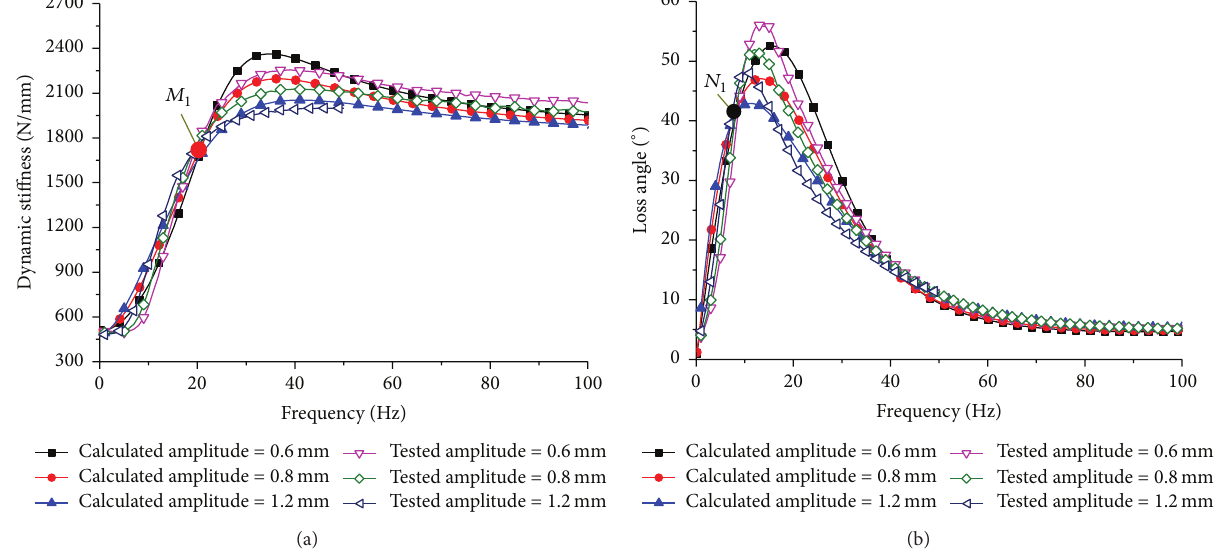
Figure 7: Comparisons between experimental and predicted results of the dynamic characteristics of HB1. (a) Dynamic stiffness. (b) Loss